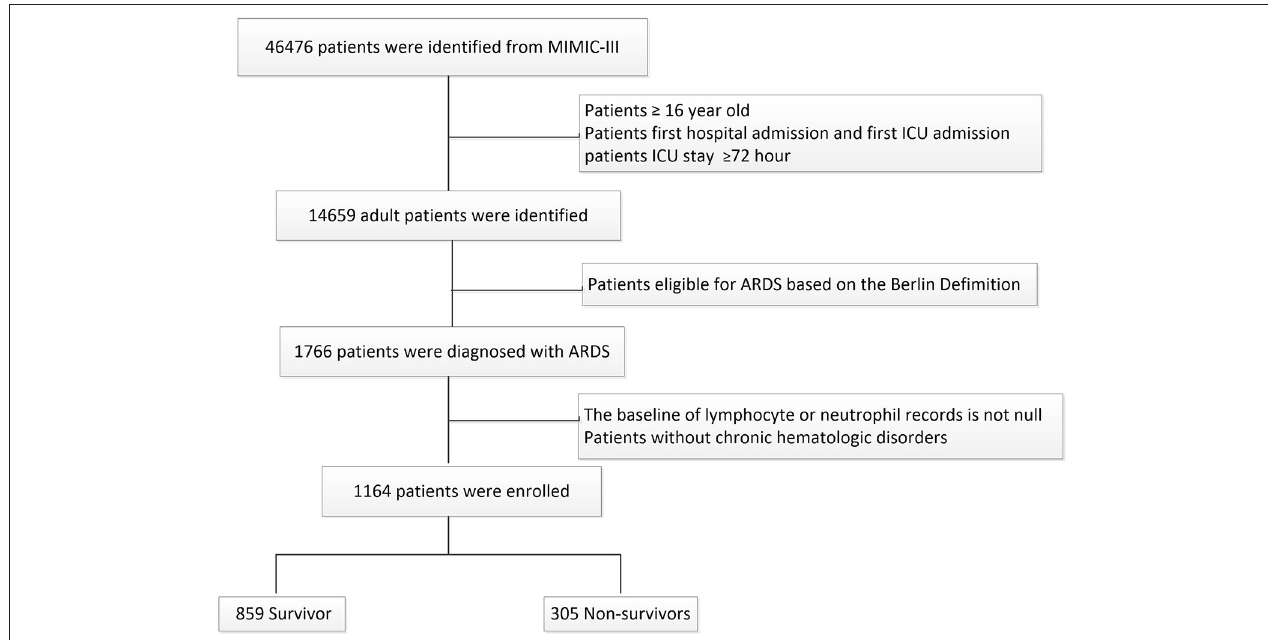
FIGURE 1 | Flow chart of the current